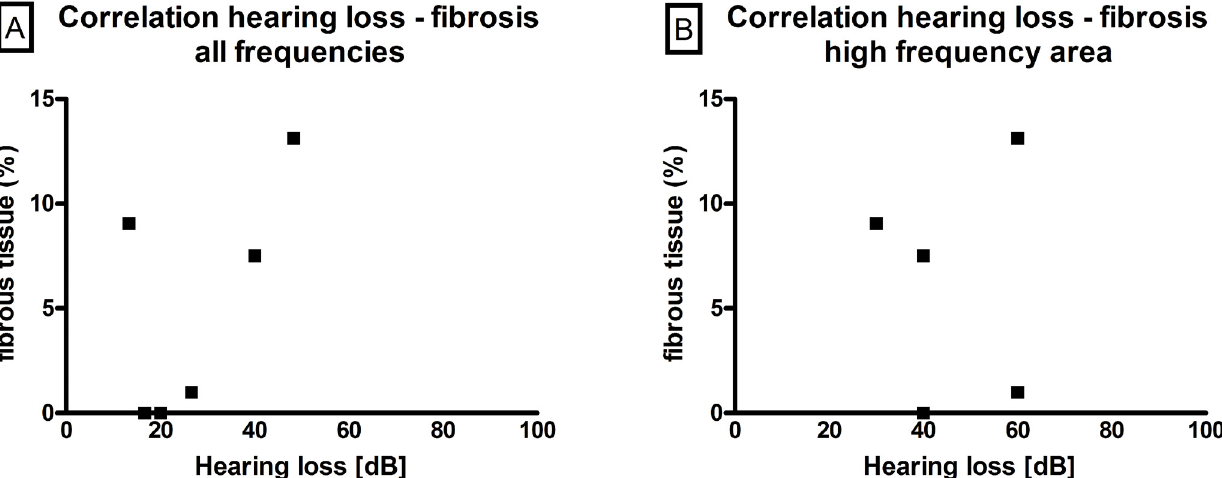
Fig 11. Correlation between fibrous tissue formation and hearing loss. No correlation between fibrous tissue growth and hearing loss, neither for all frequencies tested (1, 4, 8, 16, 32 and 40 kHz; A)) nor for the high frequencies (32 and 40 kHz; B) were observed in ears implanted with a 0% DEX-electrode array (no-electrical